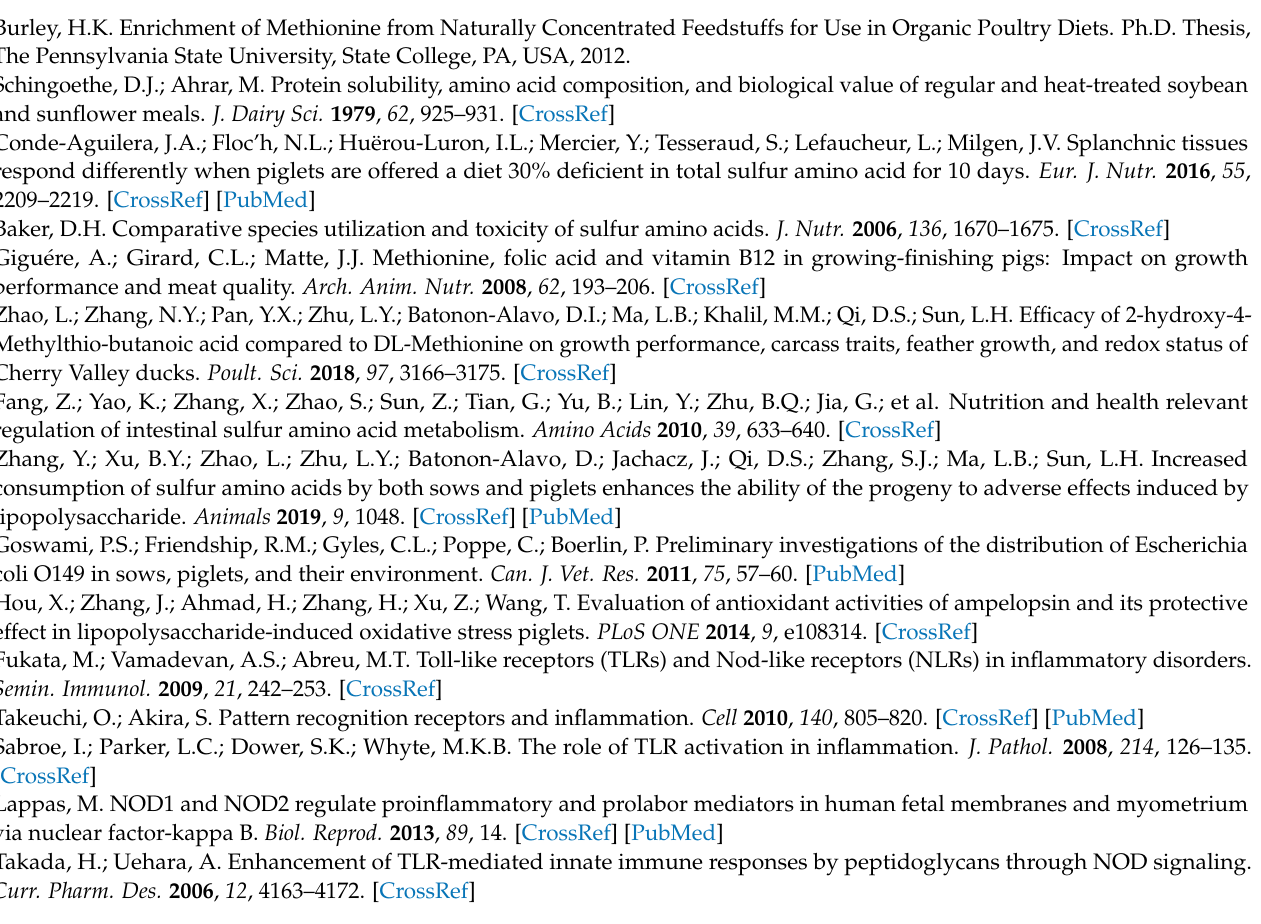
Figure S1: Schematic of the experimental procedure of the animal trial; Figure S2: Validation of the specificity of antibodies against and the correct bands of TRL4, MyD88, TRAF6, NF- κ B, p53, and